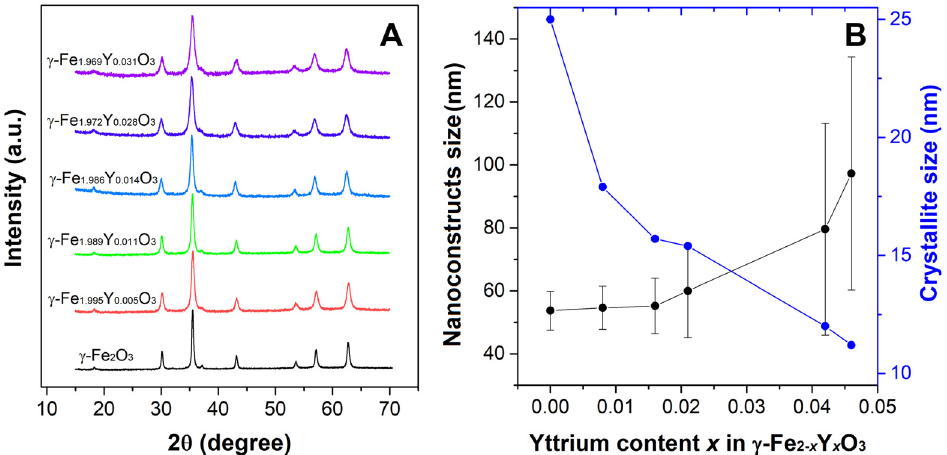
Figure 1. ( A ) X-ray diffraction patterns of γ -Fe 2- x Y x O 3 . ( B ) Dependence of nanoflowers and crystallite size on yttrium content ( x ).